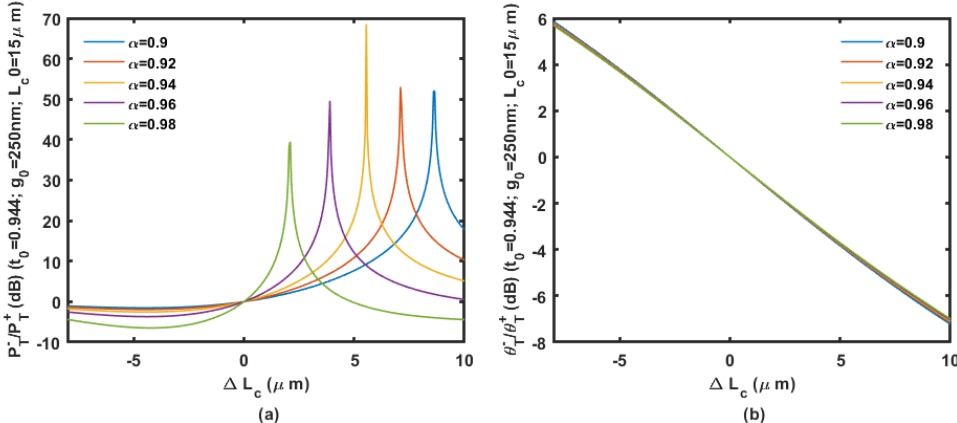
Figure 10. The power ratio ( a ) and phase ratio ( b ) according to the displacement change ∆ L c with an initial gap of 250 nm and coupling length of 15 µ